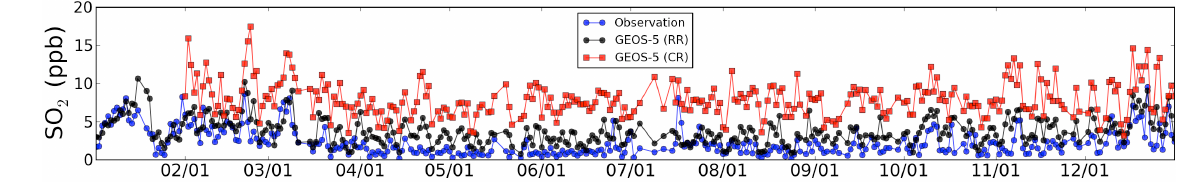
Fig. 10. Times series of daily averaged concentrations of SO 2 at the surface in 2010 at Piney Run station. Blue squares are observations, red circles are model simulations with the control run, black circles are revised model simulations.